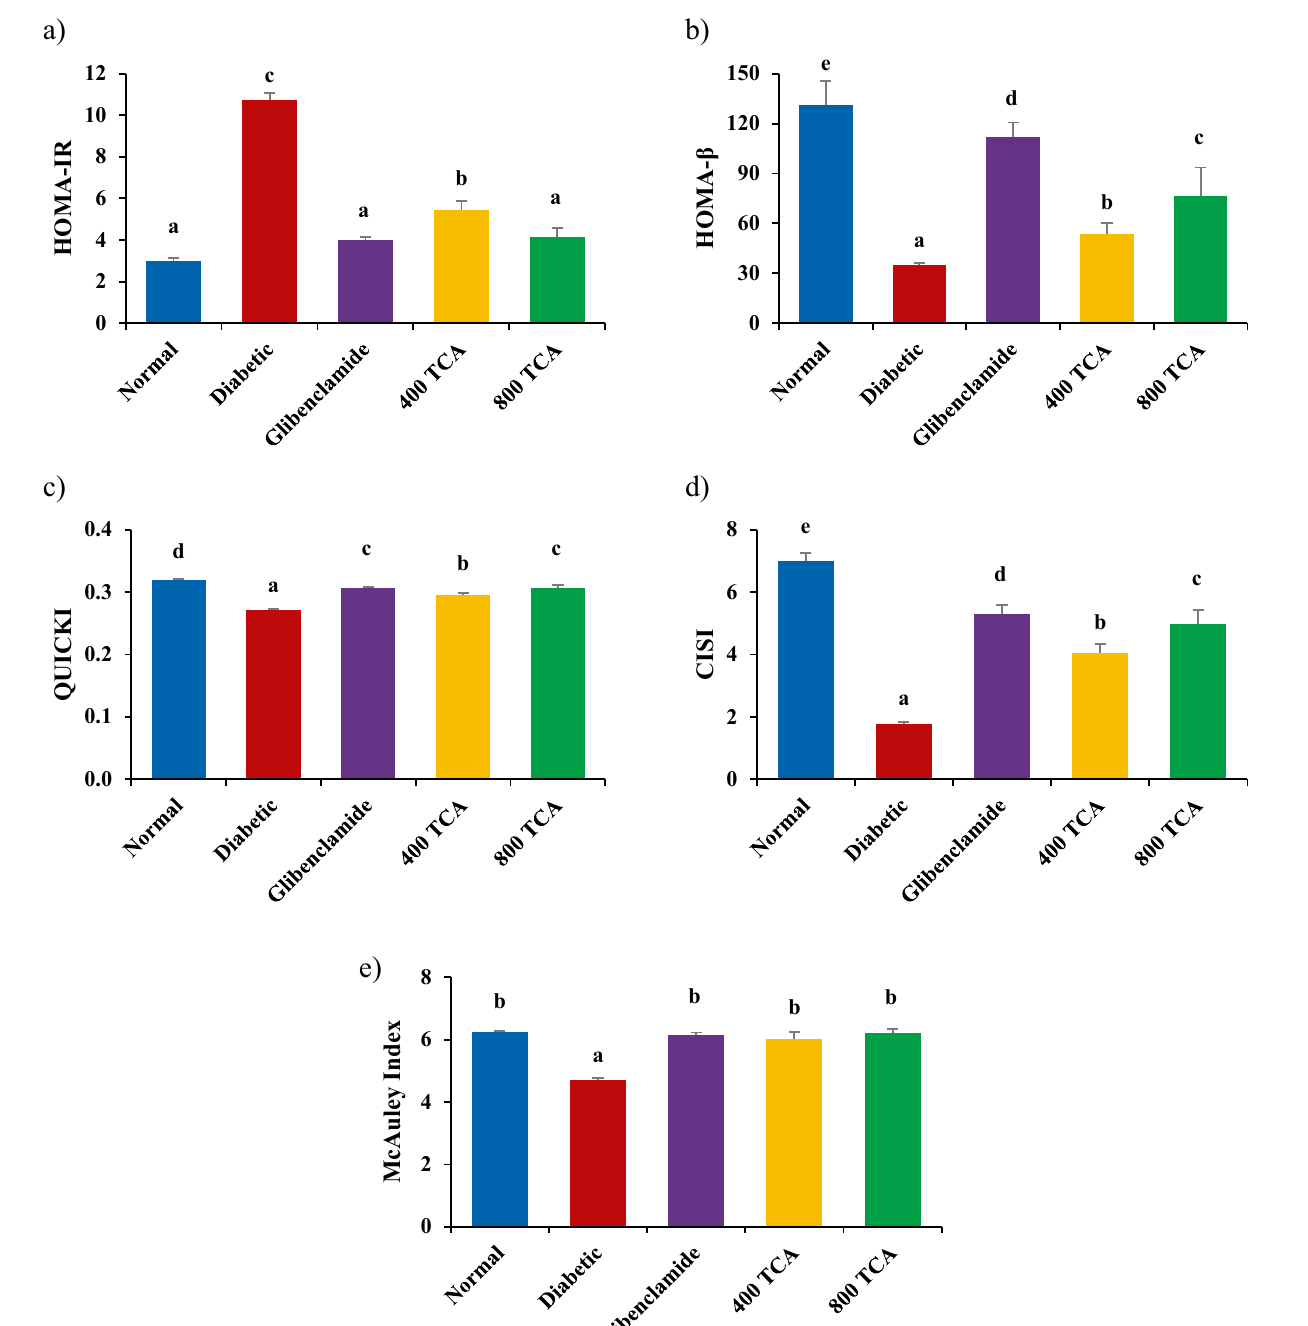
Figure 6. Effect of T. catappa aqueous extract treatment on ( a ) homeostasis model assessment for insulin resistance, ( b ) homeostasis model assessment for β-cell function, ( c ) quantitative insulin-sensitivity check index, ( d ) composite insulin sensitivity index and ( e ) McAuley index in HFD/STZ-induced diabetic rat. Bars are expressed as mean ± SEM (n = 6). Bars with different superscripts are significantly different, while those with similar superscripts are not significantly different at p <